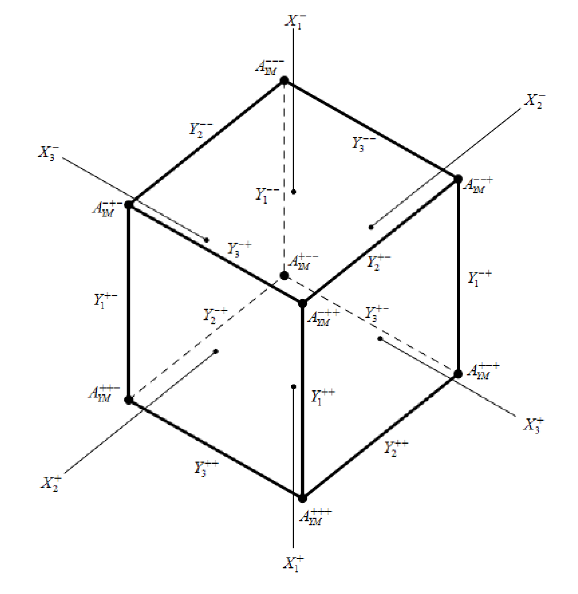
Figure 1 . The relations (3.15) represented by a cuboid, in which the X ’s are represented by the faces of the cuboid, the Y ’s are represented by the edges, and the functions A (cid:31) 1 (cid:31) 2 (cid:31) 3 ( (cid:31) i = + or (cid:0) ) YM are represented by the vertices. Each A (cid:31) 1 (cid:31) 2 (cid:31) 3 is associated with three faces and three edges to YM which the corresponding vertex is attached. Each vertex is a sum of the associated faces multiplied by perpendicular